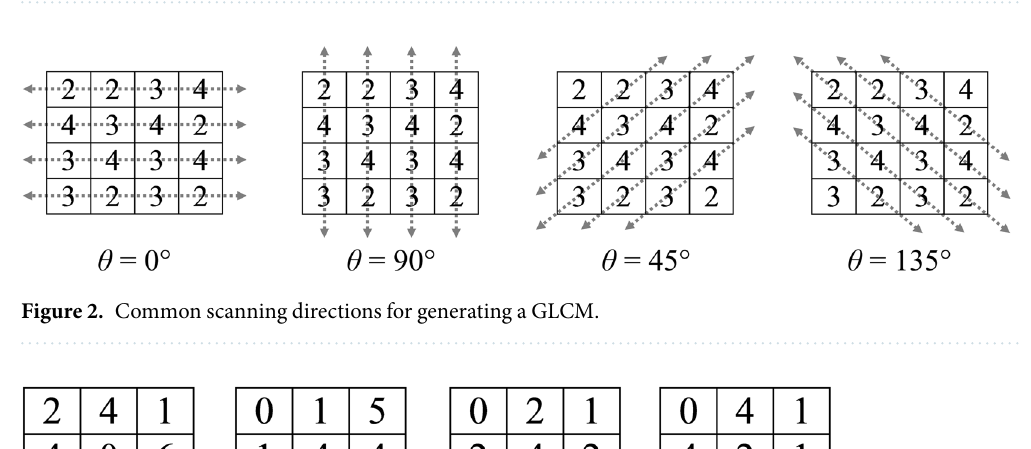
Figure 1. Schematic diagram showing the GLCM layout of an image.